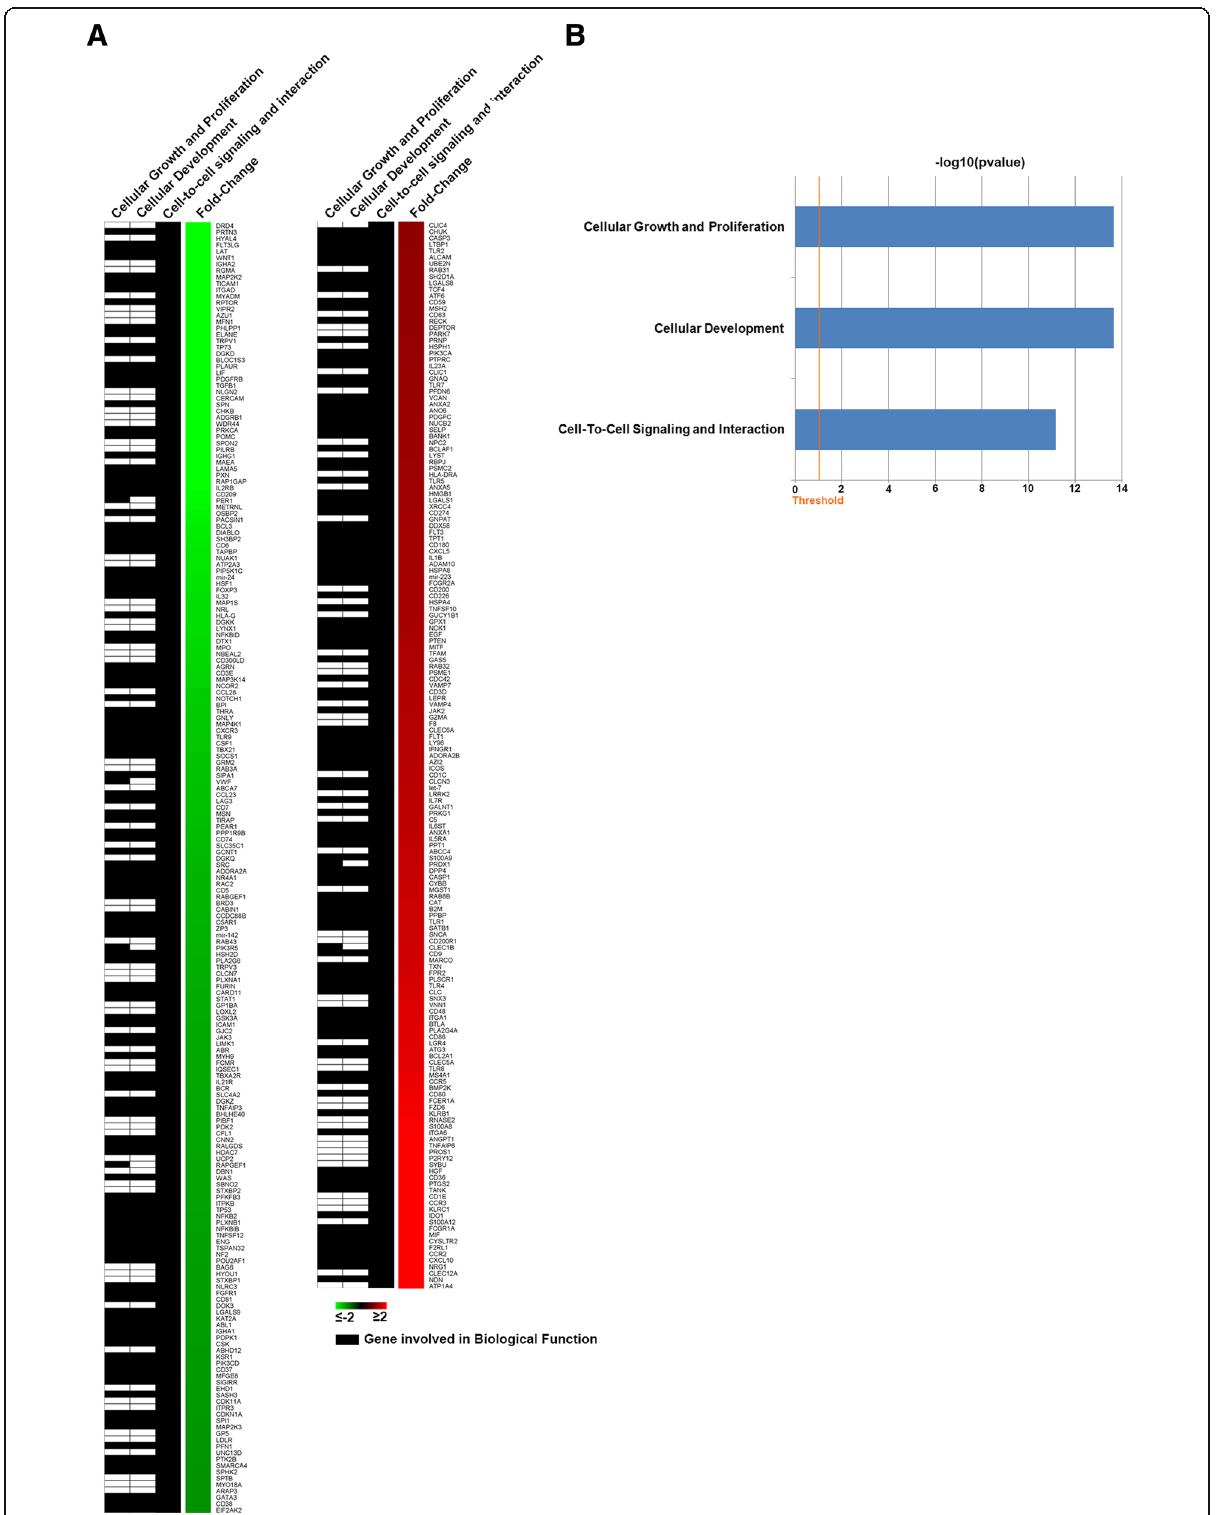
Fig. 1 Heatmap of gene functions. a . Heatmap showing the differentially expressed genes (|FC| ≥ 2 and p-adj ≤ 0.05) in whose function GAS5 is involved. b . Histogram showing the statistical significance of the functions where GAS5 is involved. The length of the bar is inversely proportional to the p